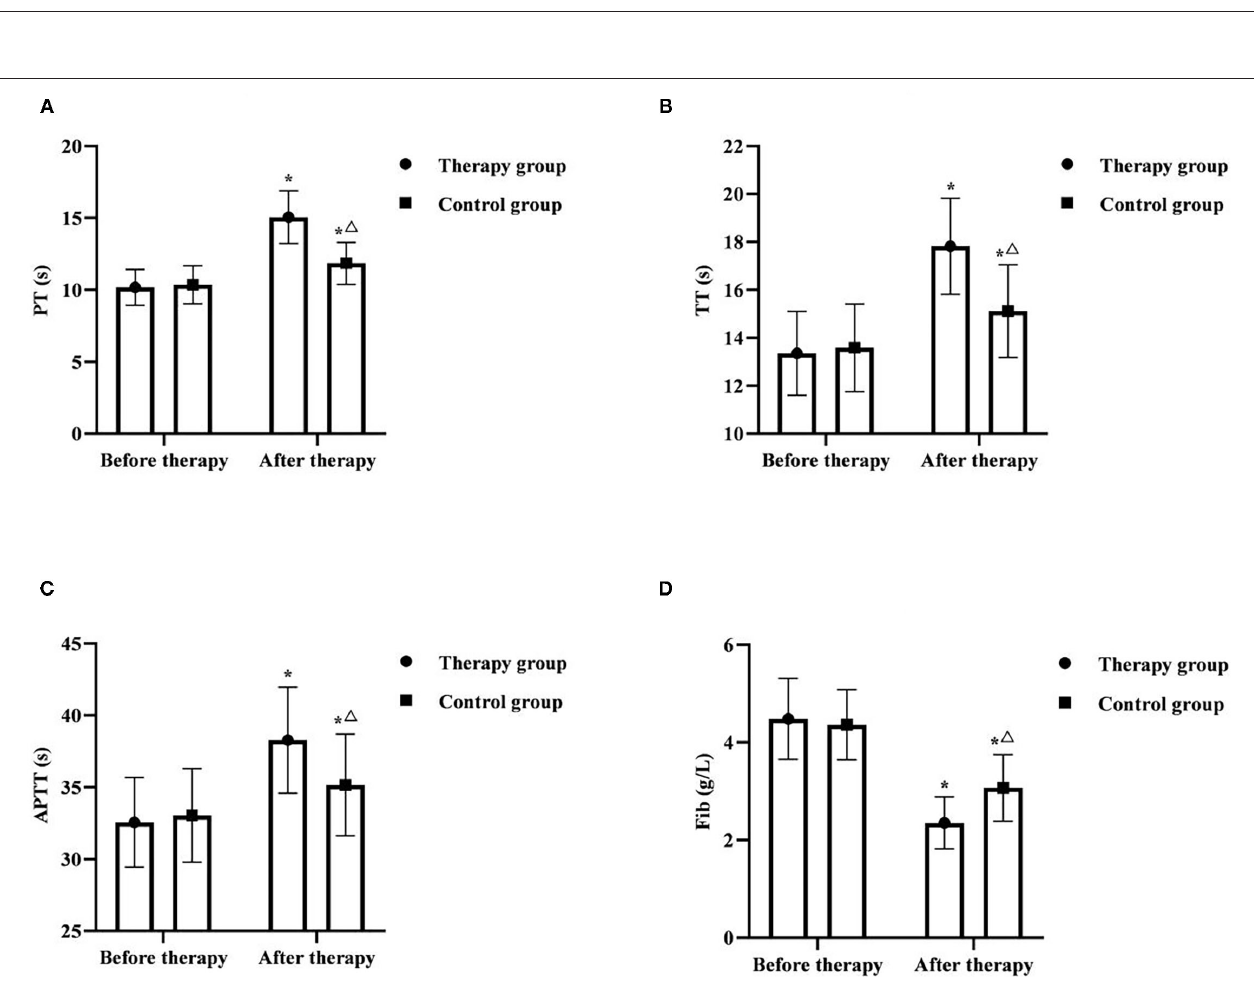
FIGURE 2 | Comparison of coagulation indexes between the two groups ( x ± s , n = 55). (A) was comparison of PT between the two groups. (B) was comparison of TT between the two groups. (C) was comparison of APTT between the two groups. (D) was comparison of Fib between the two groups. * P < 0.05 was compared with the same group before therapy, 1 P < 0.05 was compared with the control group after therapy.